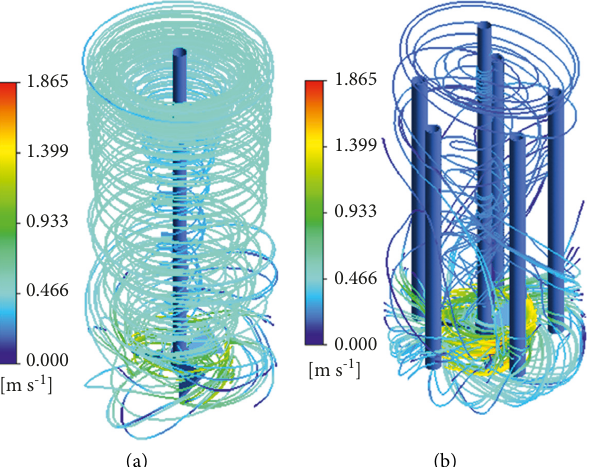
Figure 8: Three-dimensional trajectory distribution of fluid flow in the tank (displayed by the velocity). (a) Traditional stirred tank. (b) Dynamic-static combined stirred